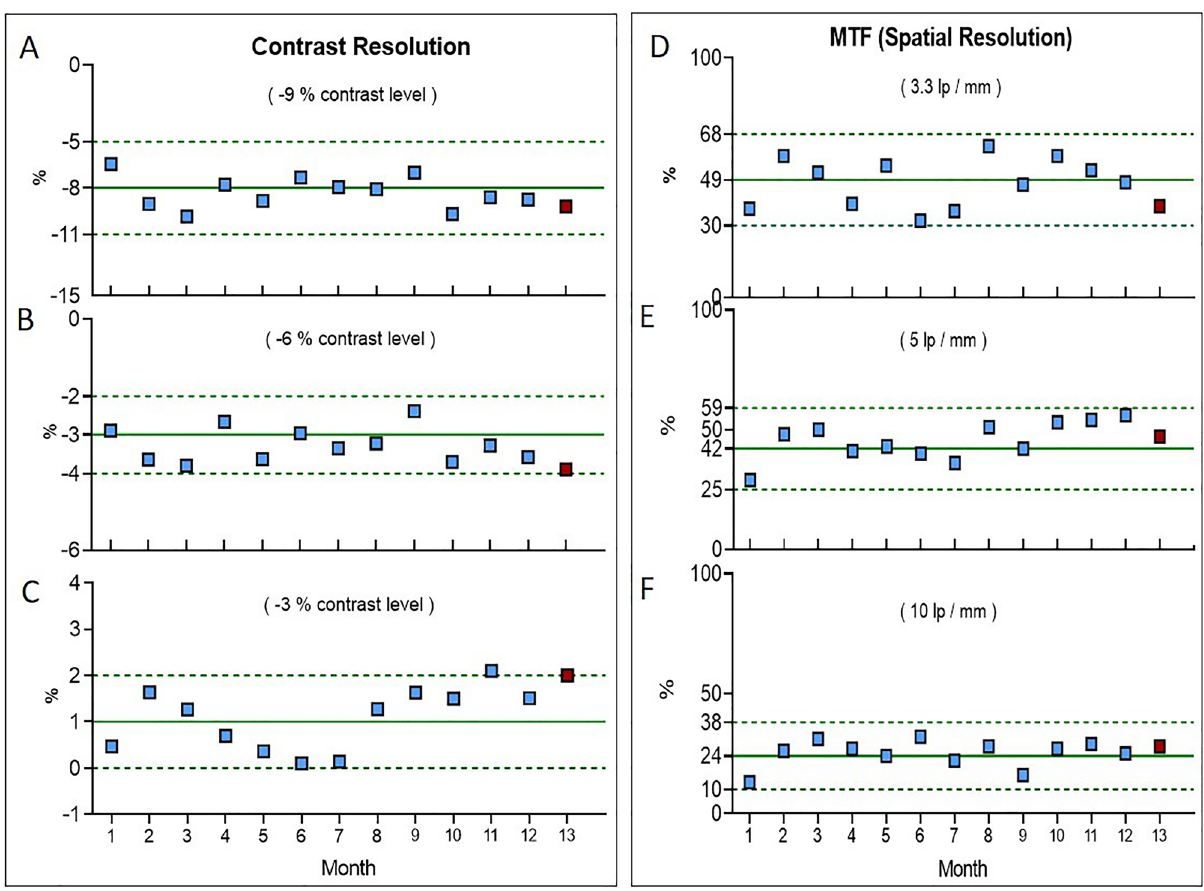
Figure 3:. ( A – C ) Low contrast control charts for the known contrast levels of − 9%, − 6% and − 3%, respectively. ( D–F ) Spatial resolution control charts, in terms of MTF%, for the three different line pairs per mm patterns: 3.3 lp/mm, 5 lp/mm and 10 lp/mm, respectively. The fluctuations of the QC parameters were monitored over 13 months. BL values (continuous lines) and acceptability ranges (dotted lines) are reported in green for each control